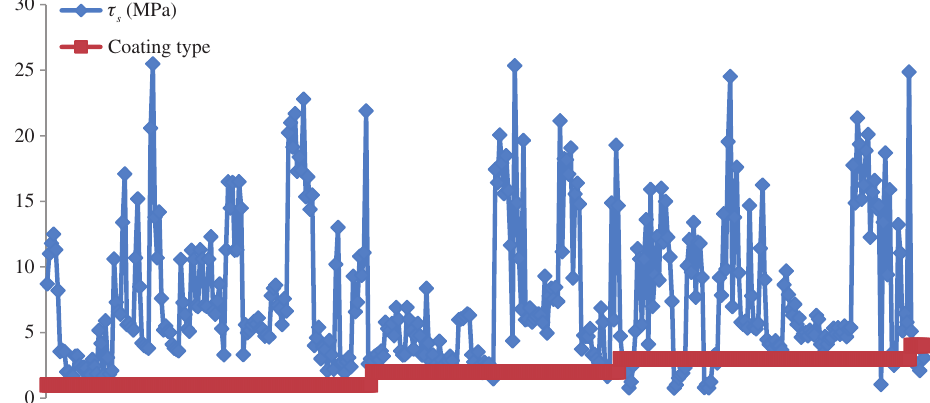
Figure 25: Change in the bond strength of FRP bars in concrete with changing FRP coating type.